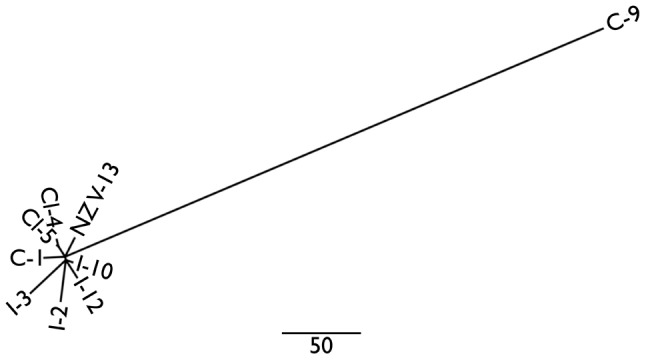
Phylogeny of Psa-V isolates and the divergent Chinese isolate C-9.Neighbor joining tree of Psa-V and C-9 isolates built in PHYLIP using SNPs due to mutation alone. These distances are also displayed in the upper right section of Table 3.